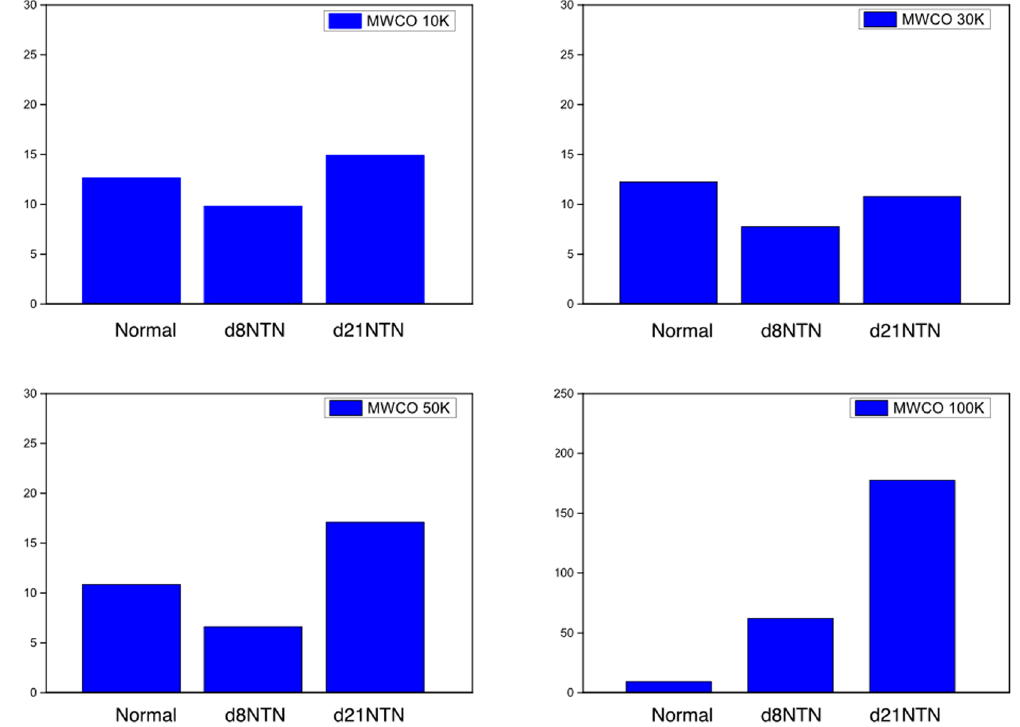
Figure 10. The 1545 cm − 1 peak intensity of the urine ultrafiltrates. Urine samples of normal, d8 NTN and d21 NTN rats were filtered through AMICON centrifugal filters with different M cutoffs of 10 K, 30 K, 50 K and 100 K, and the ultrafiltrates were analyzed. The 1545 cm − 1 component was only observed in the ultrafiltrate collected from MWCO 100 AMICON filter as it increased gradually from normal, d8 NTN (inflammation) to d21 NTN